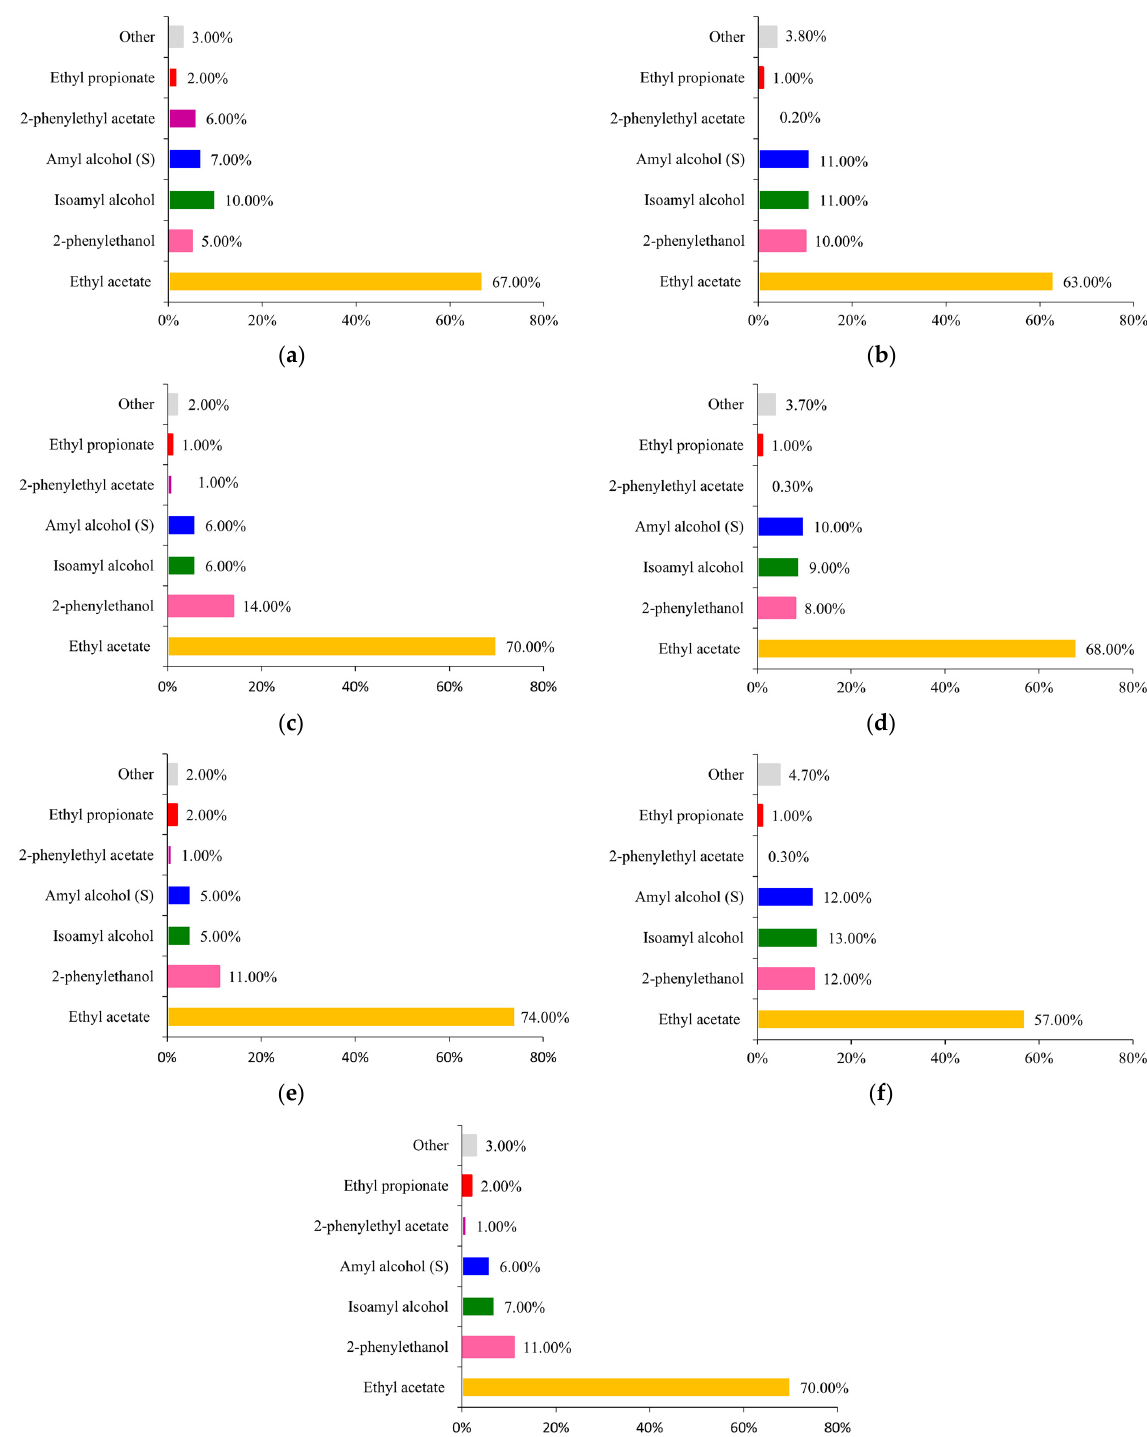
Figure 3. VOCs pro fi le in aqueous and organic samples obtained in K. marxianus WUT240 cultures in WP25 medium incubated at 30 °C, 240 rpm for 48 h: ( a ) control culture; ( b , d , f ) aqueous phase pro fi le in two-phase cultures with rice oil, rapeseed oil and linseed oil, respectively; ( c , e , g ) organic phase pro fi le in two-phase cultures with rice oil, rapeseed oil and linseed oil, respectively.